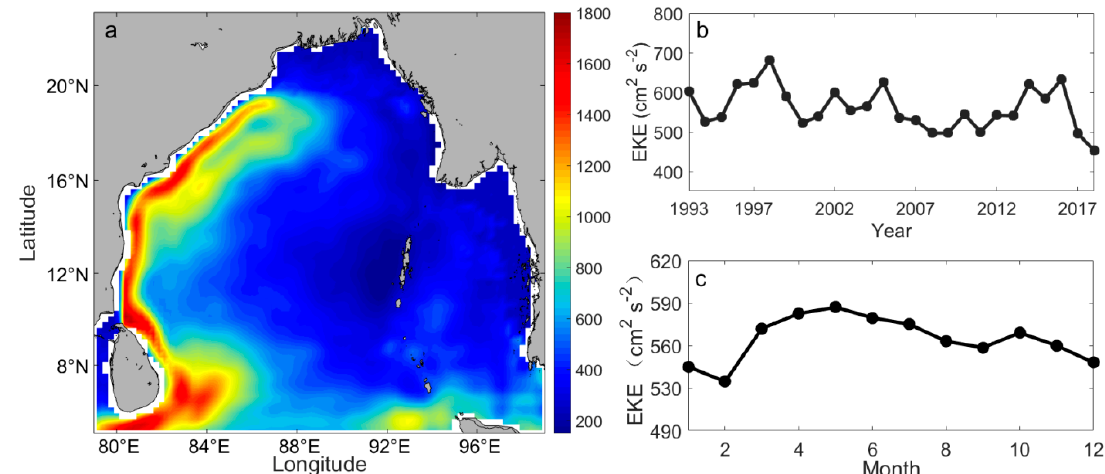
Figure 4. ( a ) Spatial distribution of the multi-year average eddy kinetic energy (EKE) over the period of 1993 ‒ 2018; ( b ) the interannual variation of area-averaged EKE; ( c ) the seasonal variation of the area-averaged EKE (unit: cm 2 /s 2 ).